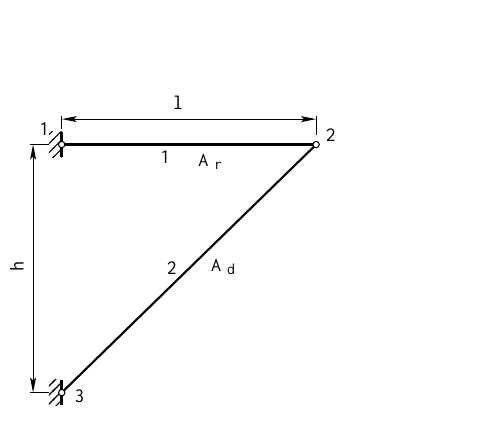
Fig. 5. Truss structure. Fig. 6. Indices of state vector components.